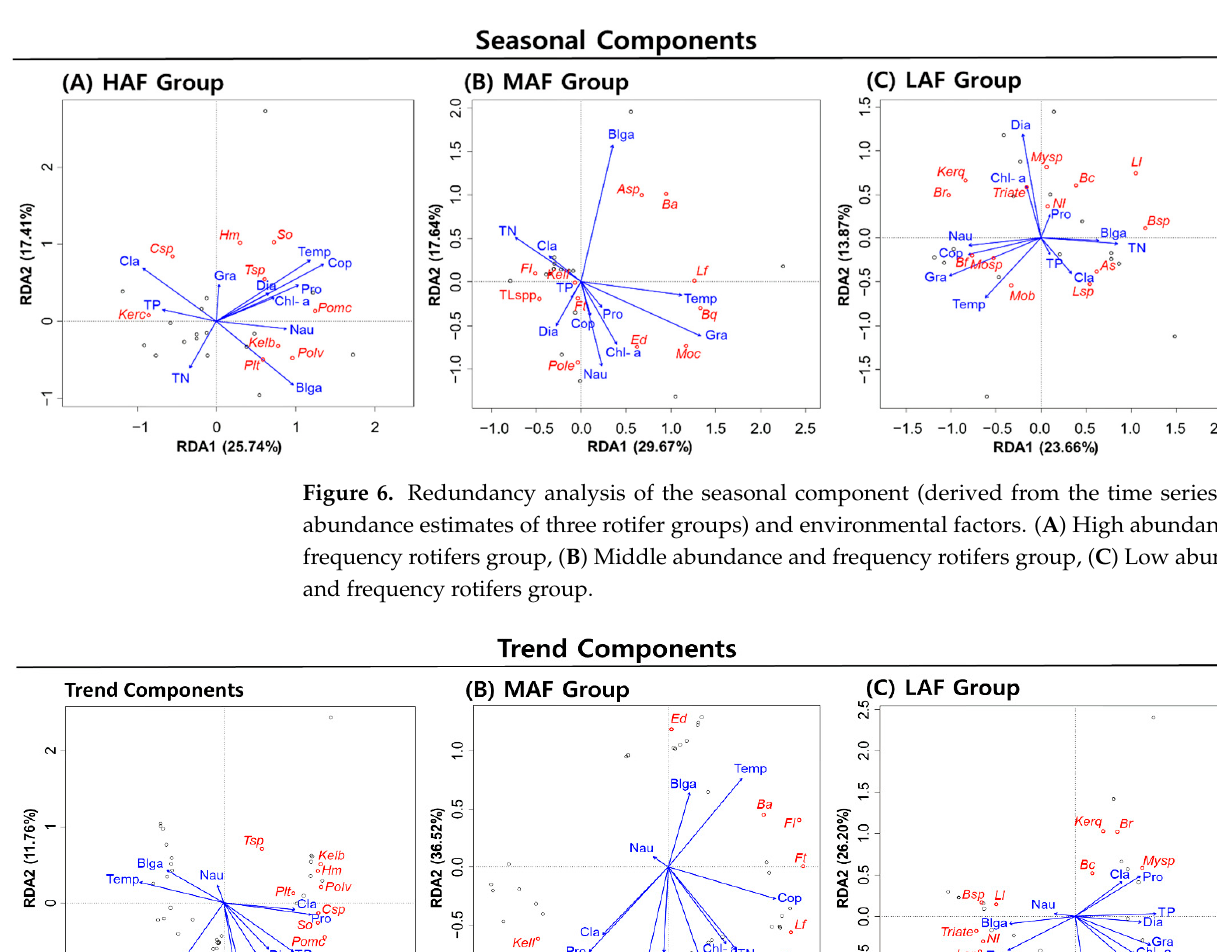
Table 2. Summary of the community data (number of individuals, number of species ratio, and frequency) for rotifer species abundance and frequency 2017–2019 in Daecheong Lake.